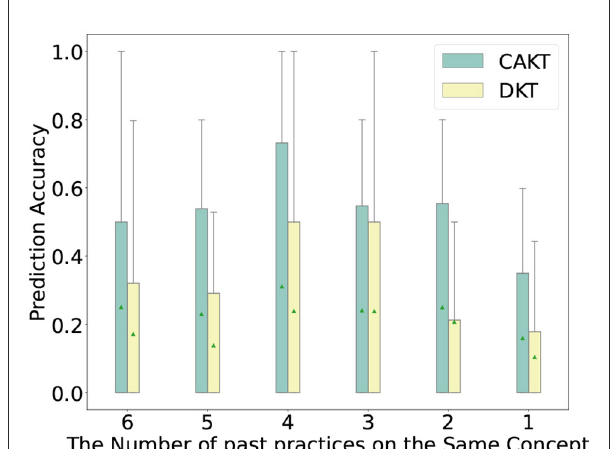
FIGURE6 Prediction accuracy for interactions with different number of past practices on the same knowledge concept, CECAKT Vs. DKT.